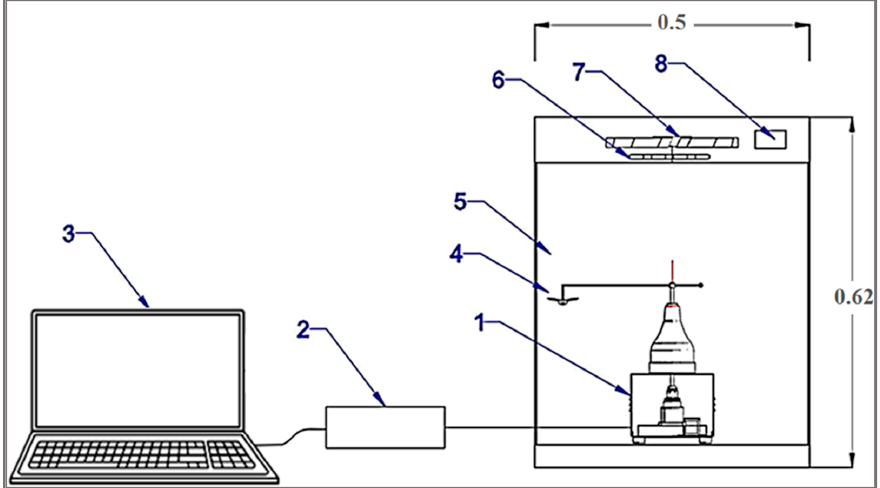
Figure 1. Components of the computerized flight-testing mill. (1) flight mill, (2) USB digital oscilloscope, (3) laptop, (4) tested insect, (5) test chamber, (6) heater, (7) fan, (8) temperature controller.